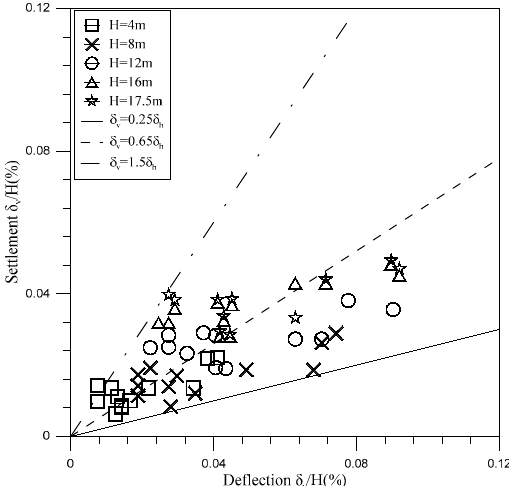
Figure 20. Deflection and settlement of the retaining wall (nodes 0–11).